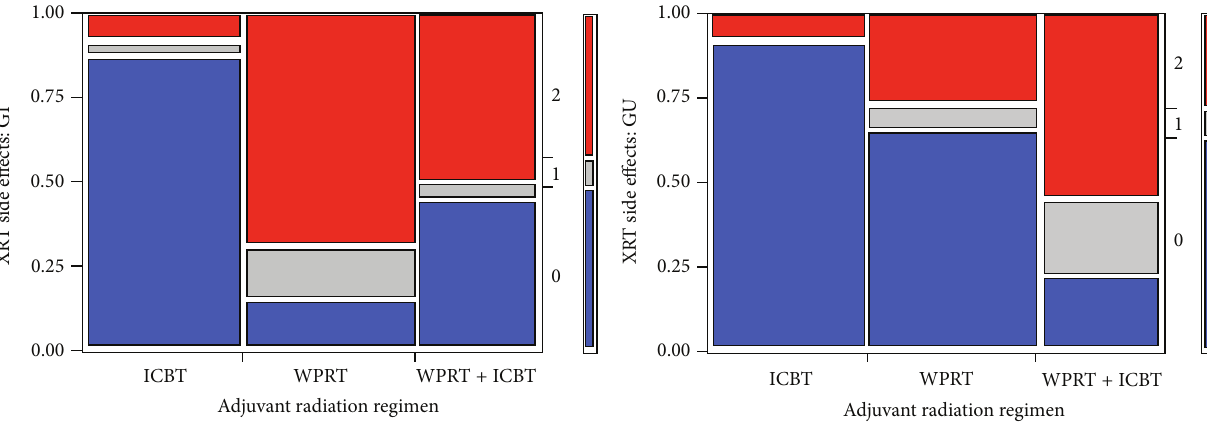
(b) Left panel: gastrointestinal toxicities versus radiation regimen. Right panel: genitourinary toxicities versus radiation regimen Figure 1: Effect of mean BMI on acute radiation toxicities. (a) Logistic regression curve modeling gynecologic and cutaneous acute toxicities versus mean BMI. (b) Bar graph depicting ratio of gastrointestinal or genitourinary acute toxicities versus adjuvant radiation treatment prescribed (WPRT, ICBT, or combination of WPRT +